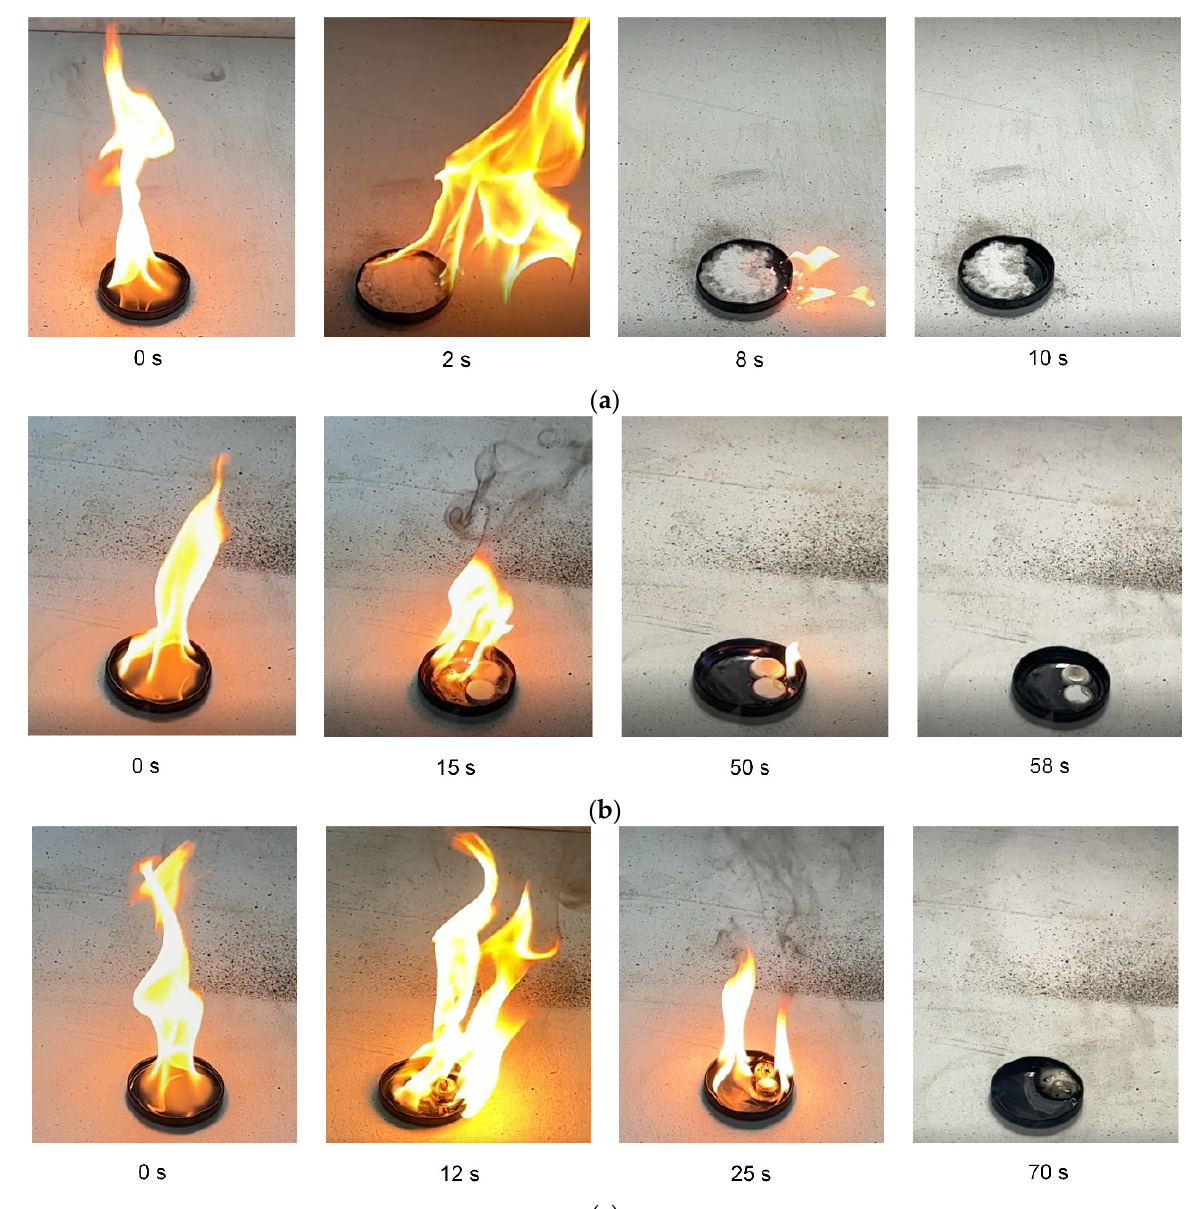
Figure 2. Images of gasoline fire suppression ( V 0 ≈ 3 mL) with the help of carbon dioxide hydrate in the forms of ( a ) powder, m g ≈ 4 g; ( b ) tablets, m g ≈ 1.07 g; ( c ) spheres, m g ≈ 1.42 g ( d f ≈ 65 mm, S f ≈ 33 cm 2 ).